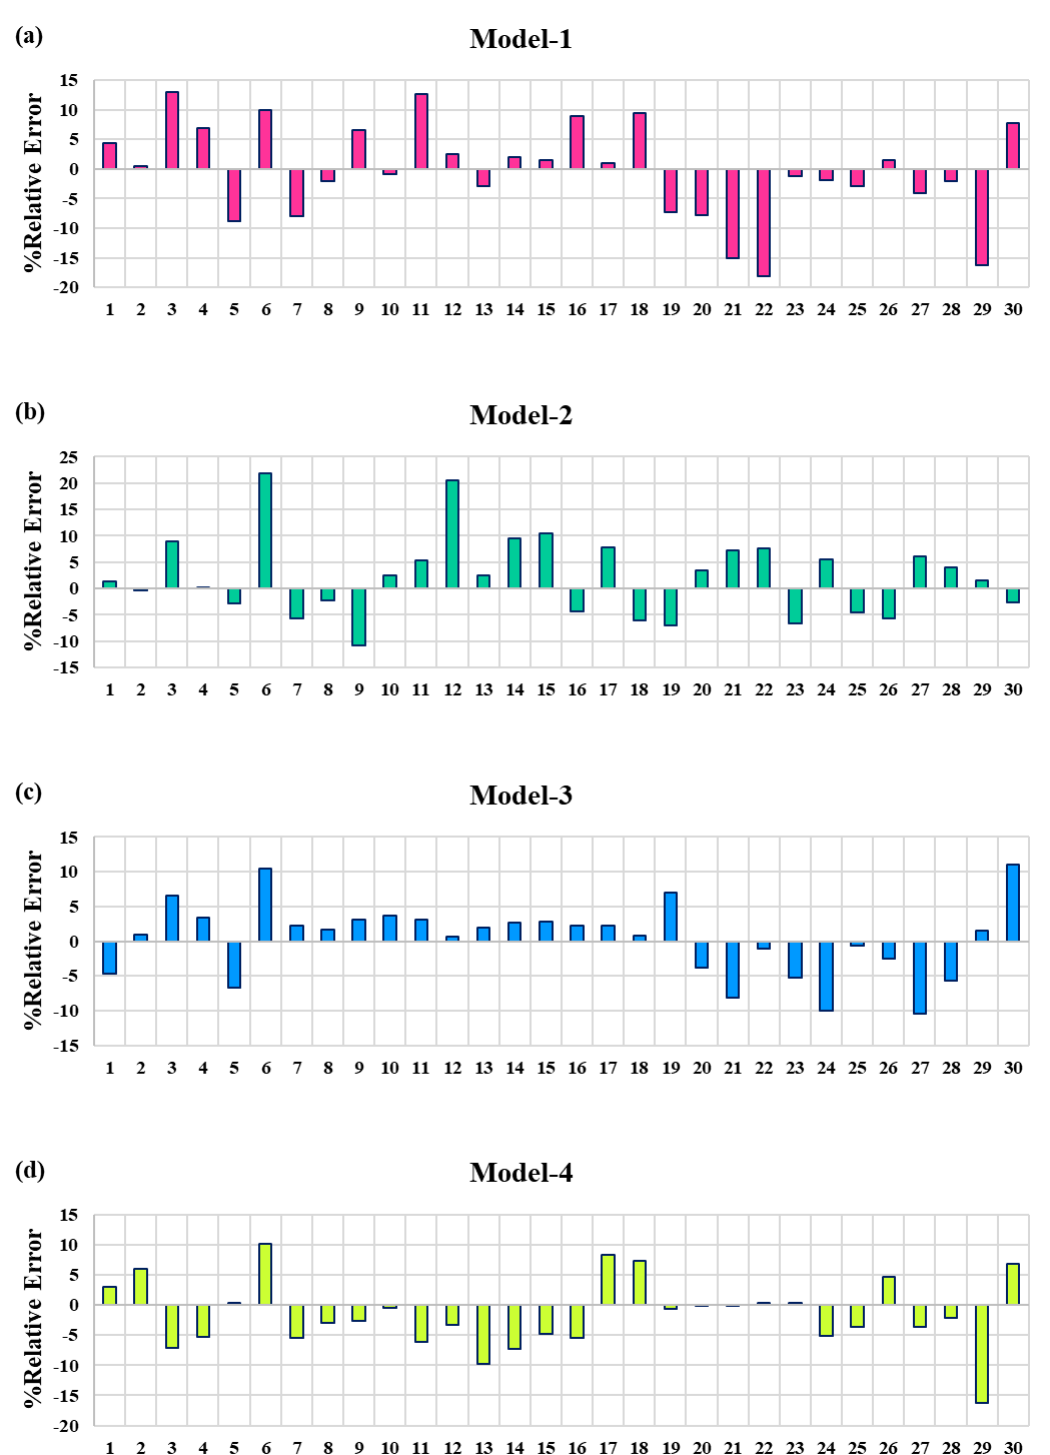
Figure 9. Distribution of the relative error through examination interval for all models using MLPNN method.